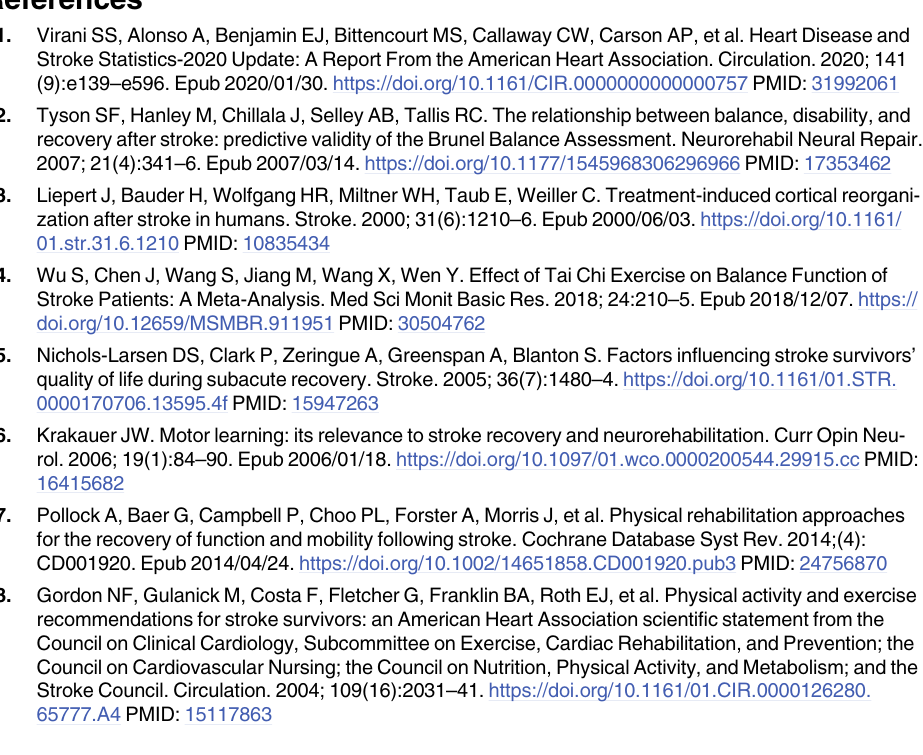
S2 Table. Korean and Chinese search